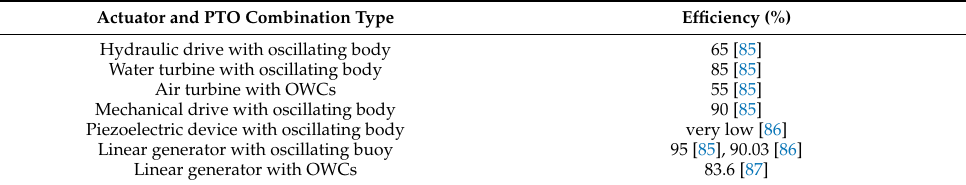
Table 5. Efficiencies of different